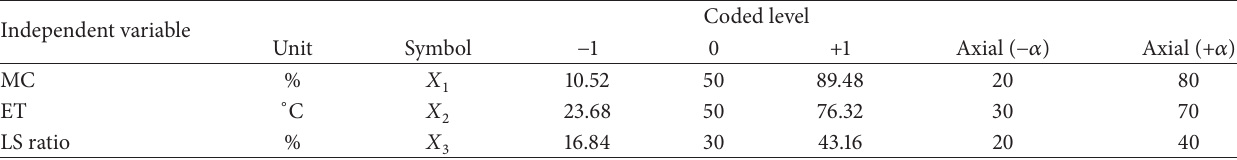
Table 1: Independent variables and their coded and actual values used for optimization.